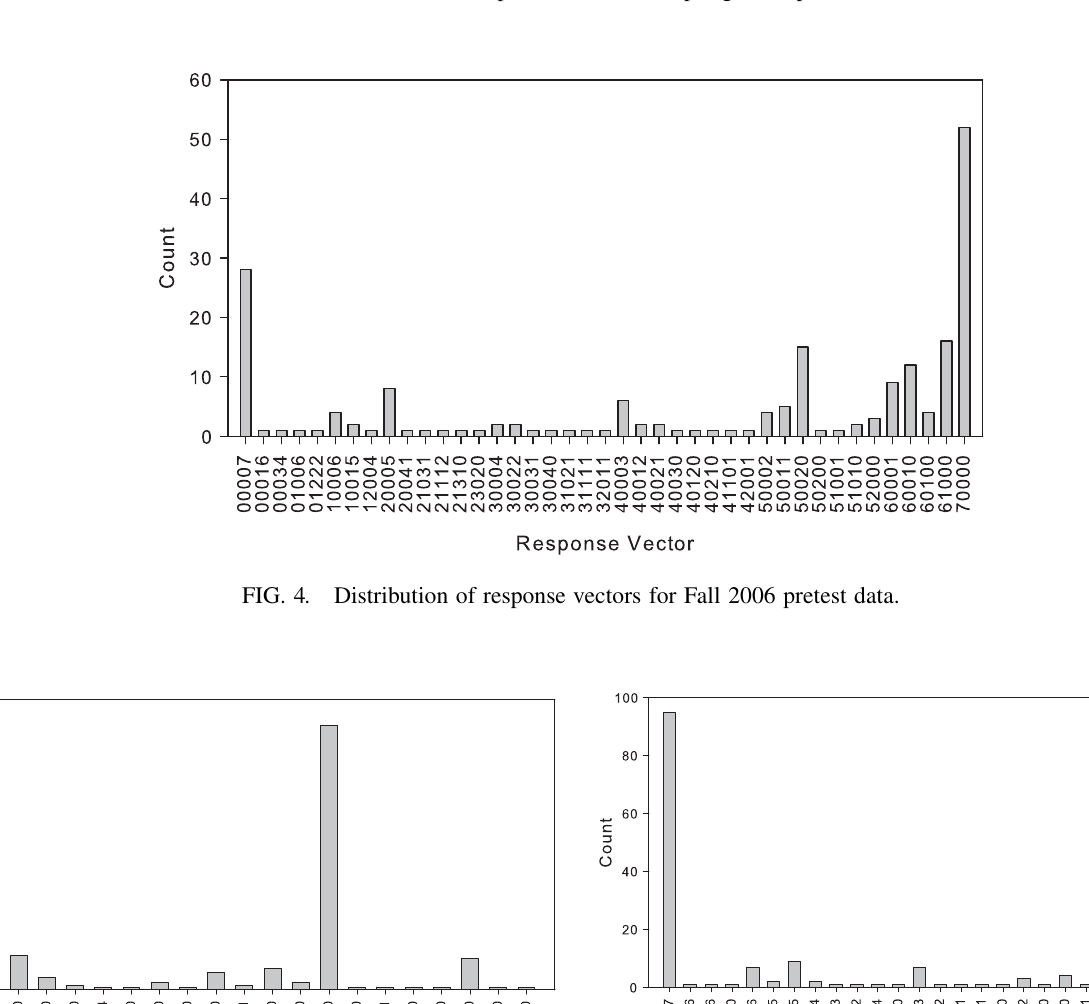
FIG. 3. Distribution of response vectors for Spring 2006 pretest data.